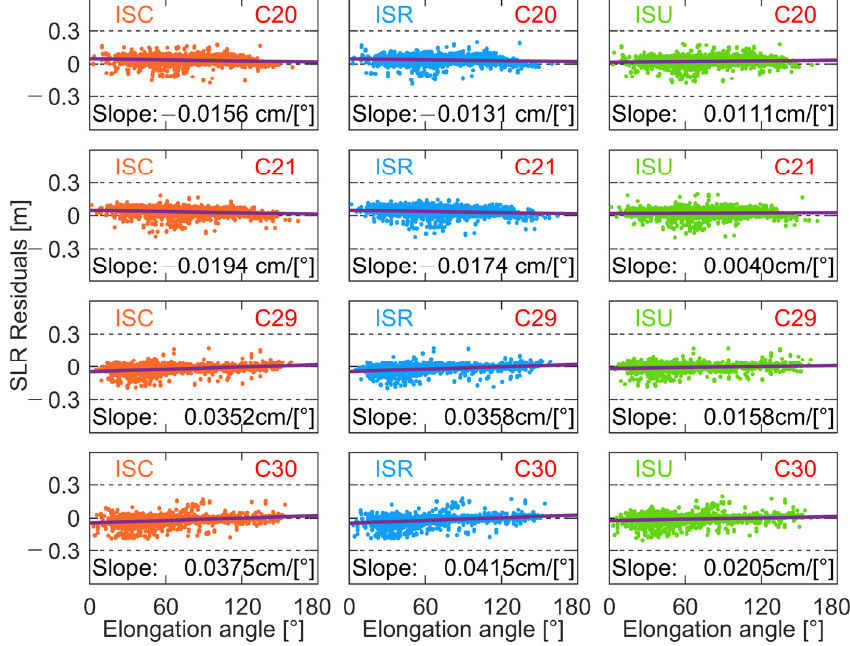
Figure 19. SLR residuals of BDS-3 satellites based on three types of iGMAS B1I/B3I orbits versus elongation angle.